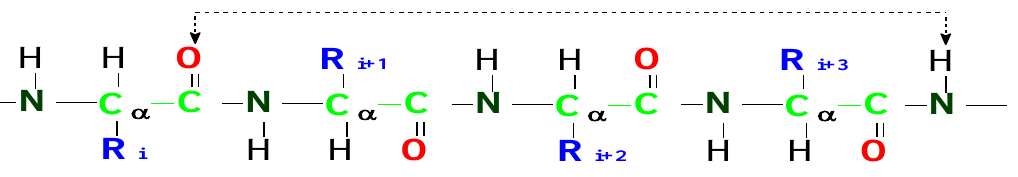
Figure 1. Spin helicity through the hydrogen of peptide bond.